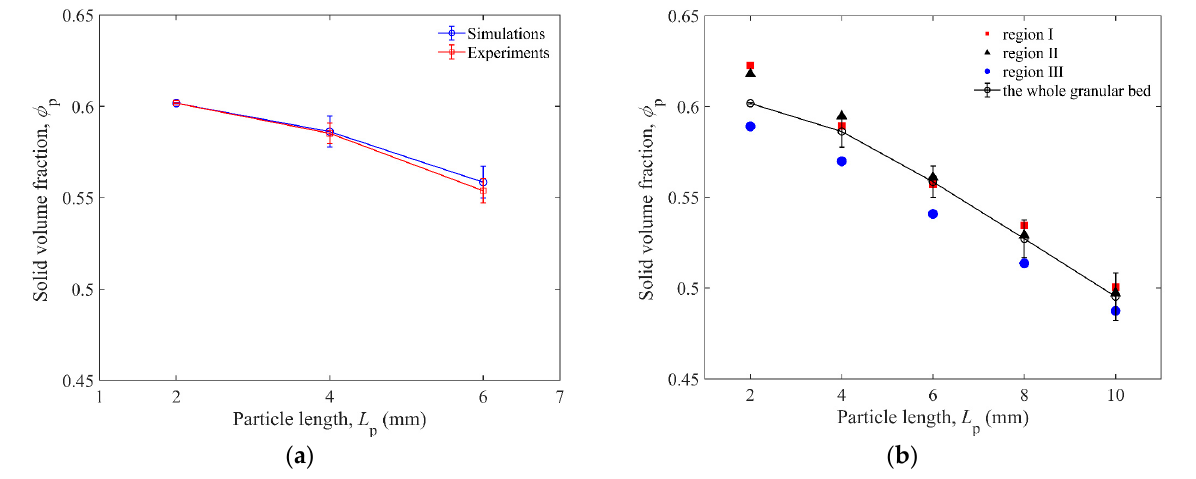
11 of 23 Figure 9. Diagram of sub-region division for granular bed. Region Ⅰ : 0 < R 1 < 2/7 R c ; region Ⅱ : 2/7 R c < R 2 < 5/7 R c ; and region Ⅲ : 5/7 R c < R 3 < R c . (The particles count in one region if their mass centers fall in this region; R c is the radius of the cup). Figure 10a shows the comparison of solid volume fractions for granular beds com-